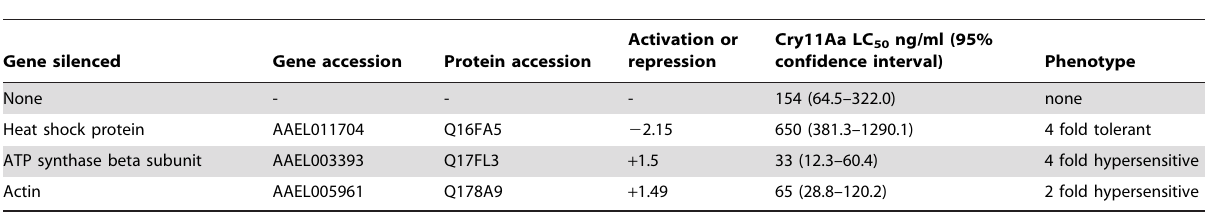
Table 2. Susceptibility to Cry11Aa toxin intoxication after silencing the protein expression of selected targets by RNAi.